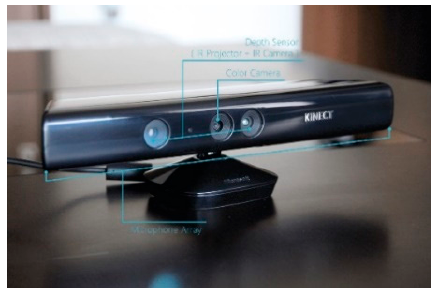
Figure 3. Microsoft Kinect V1.0 composition diagram. Table 1. Microsoft Kinect V1.0 parameter list.